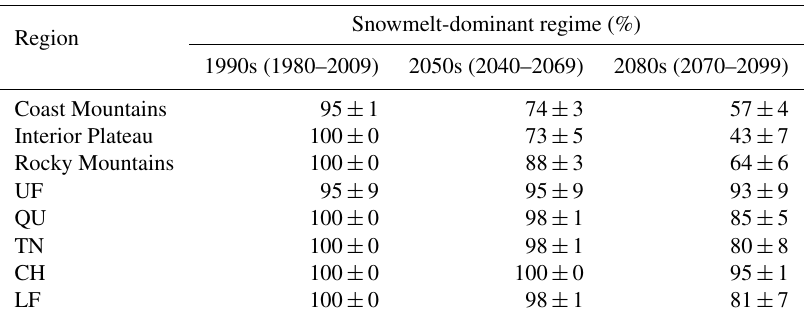
Figure 7. CMIP5-VIC-simulated daily peak runoff (a) and corresponding day of the peak runoff (b) in the cold season of the water year for the Coast Mountains, Interior Plateau and Rocky Mountains. Solid curves are for the MME mean, and shading represents inter-model spread, as represented by a 5%–95% model range. A 5-year running mean is applied to smooth variations in all curves; y -axis values in (b) represent days of water year, where 0 corresponds to 1 October. (c) Cold season peak runoff (in mm) simulated by individual CMIP5-VIC simulations for the Coast Mountains. Table 3. CMIP5-VIC-simulated projected change in snowmelt-dominant regimes. Values are in % calculated using the ratio of the sum of SP years and the total number of years over all 21 CMIP5-VIC simulations. The uncertainty ranges ( ± ) indicate inter-model spread in the MME mean values, indicated by a 5%–95% model